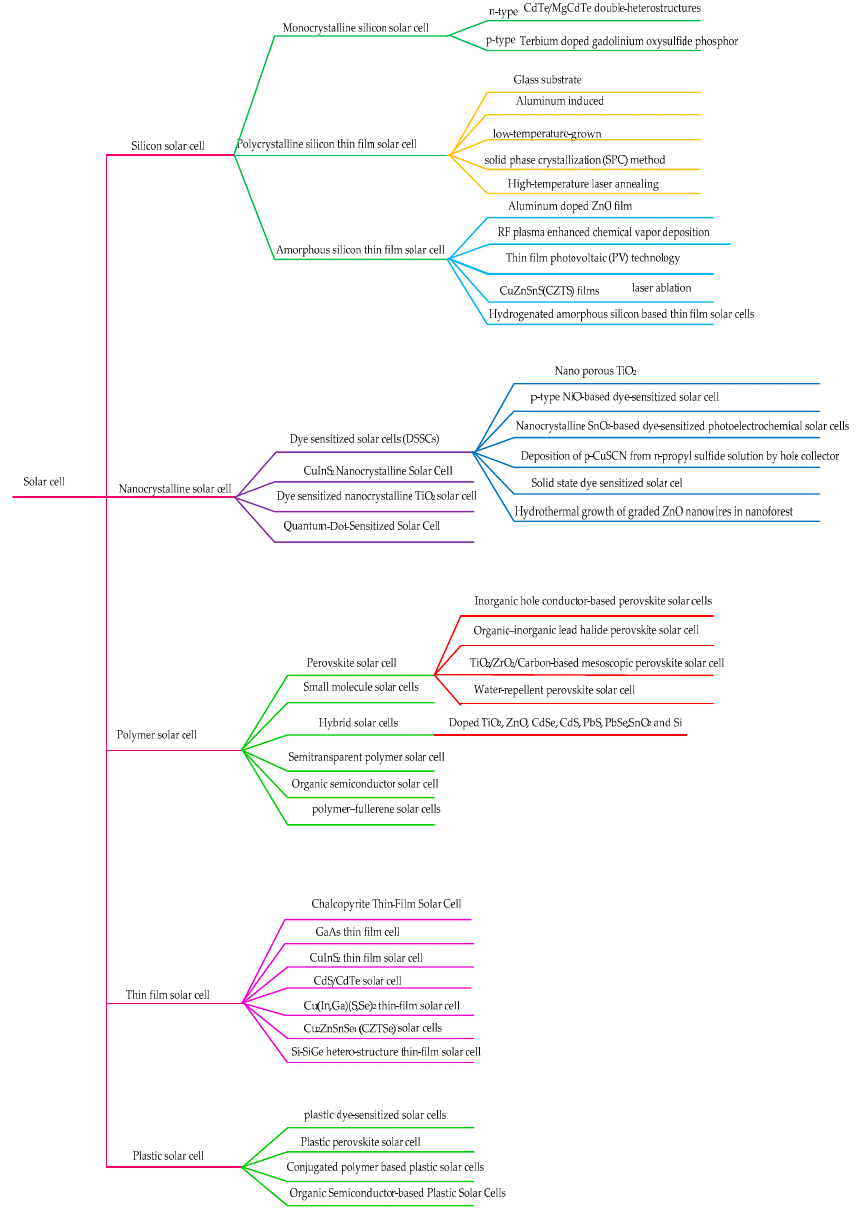
Figure 5. Classification of solar cells.